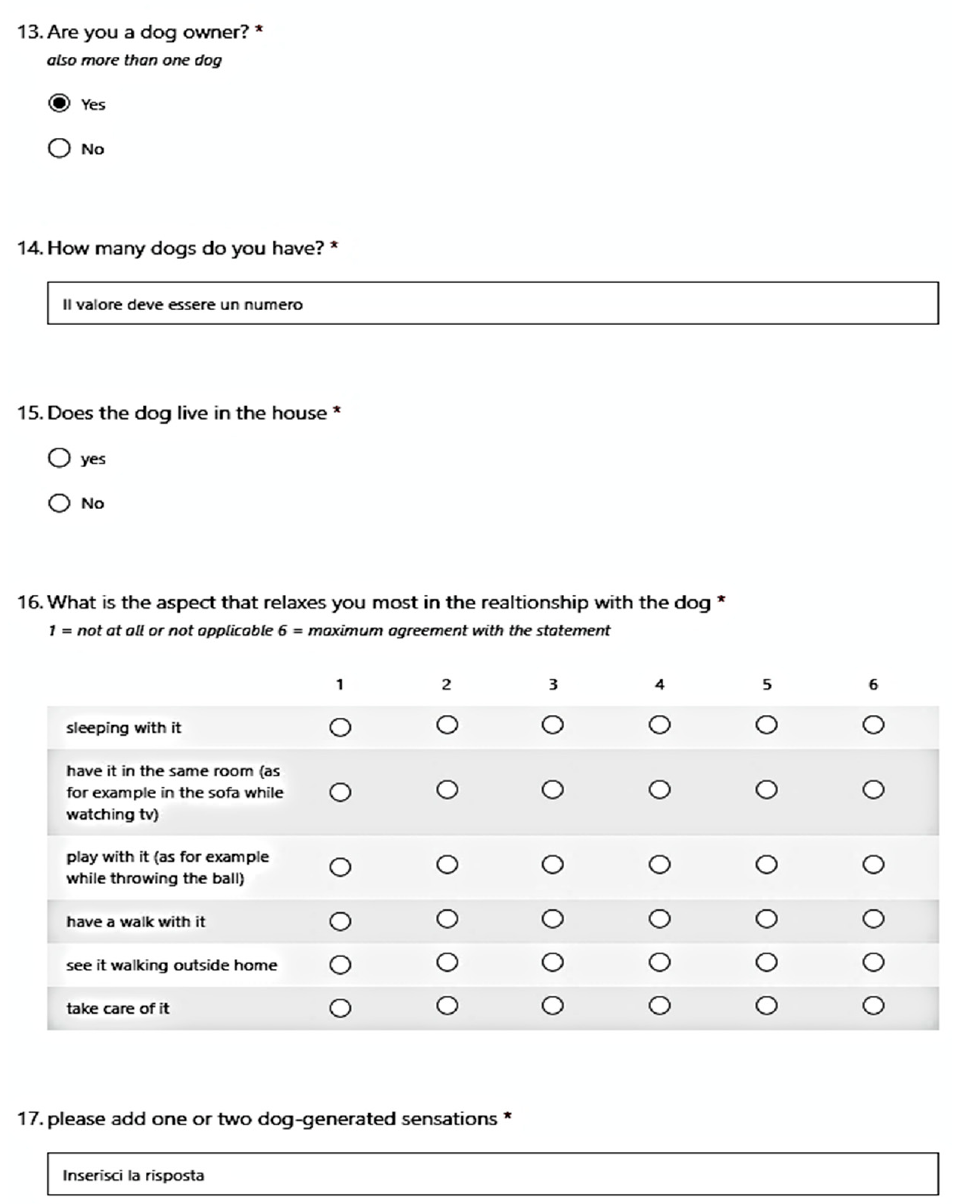
Figure A1. Tool Section dedicated to the questions about the interaction with the dog. “*” means mandatory questions.